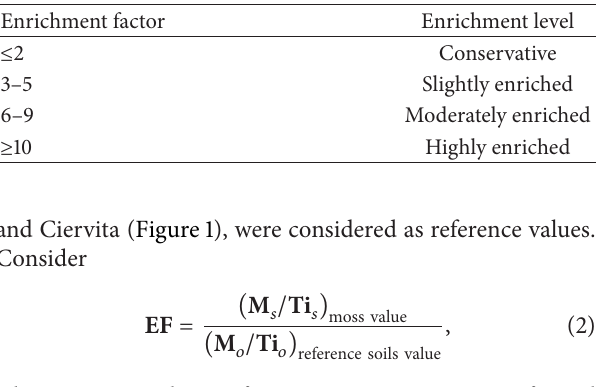
Table 2: Criteria for evaluated moss enrichment